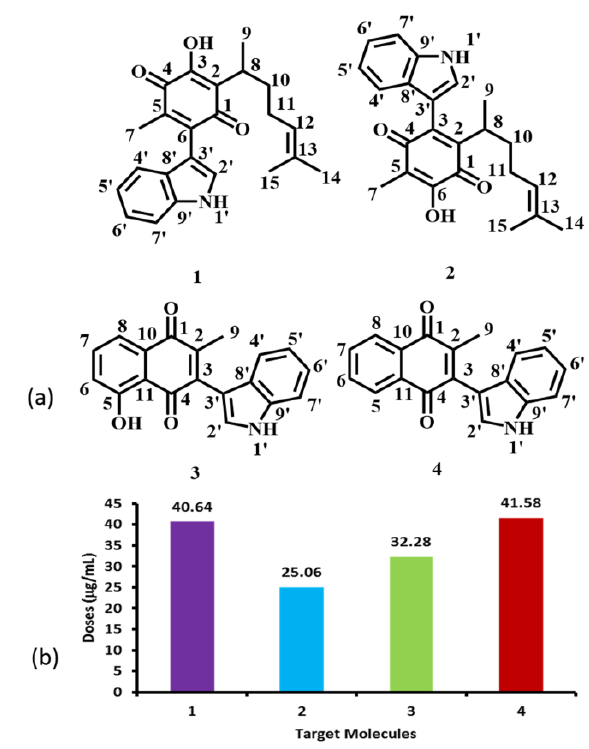
Figure 2. Cytotoxic effect of indolylquinones in cancer breast cells. ( a ) Atom numbering assignments of compounds 1 – 4 . ( b ) Histogram of the corresponding IC 50 values.